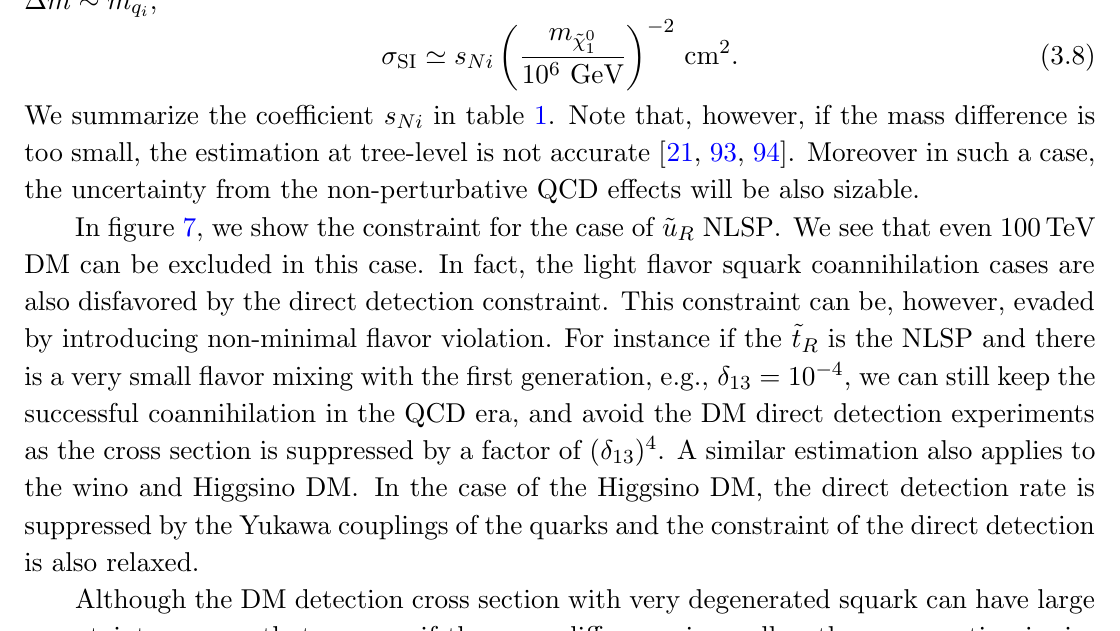
Table 1. The coe(cid:14)cients for the direct detection in eqs. (3.7) and (3.8). for the nucleon N and squark ~ q i = ~ u; ~ d and ~ s . For the heavier (cid:13)avor ~ q i = ~ c and ~ b ,